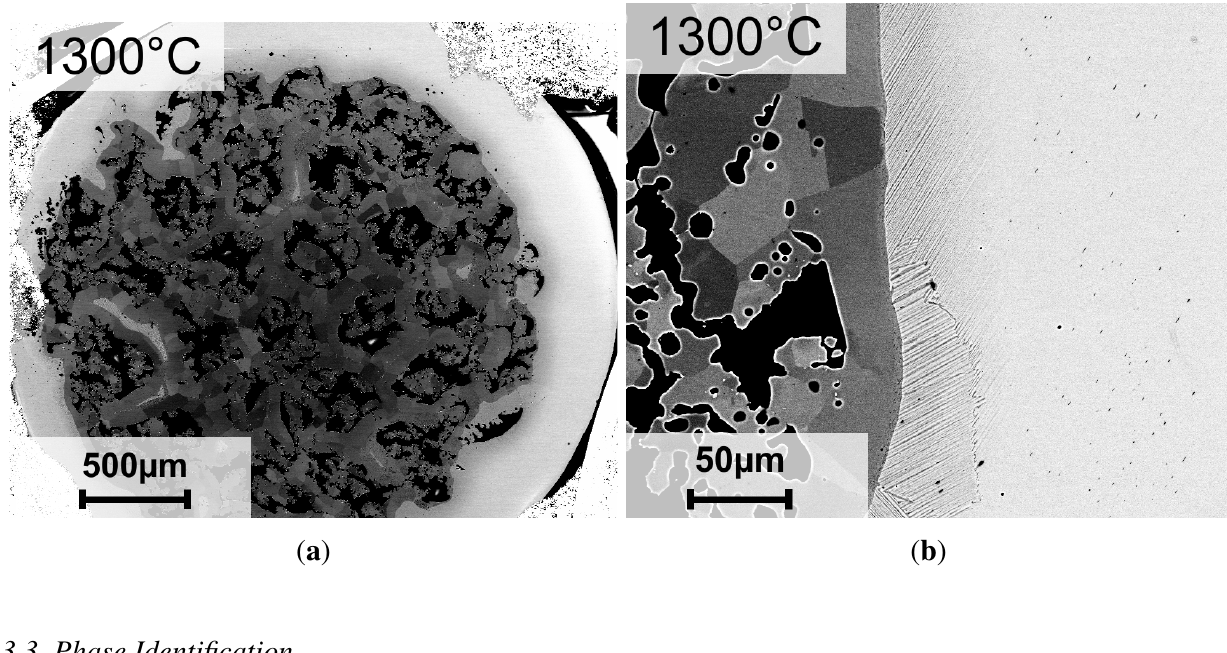
Figure 6. BSE images: ( a ) Overview of the wire (same sample as in Figure 1c. Outer region is Ti rich, while the dark core is mainly composed of γ -TiAl; ( b ) shows the transition region from the core (left side) to the shell (right side). Note the fine lamellar